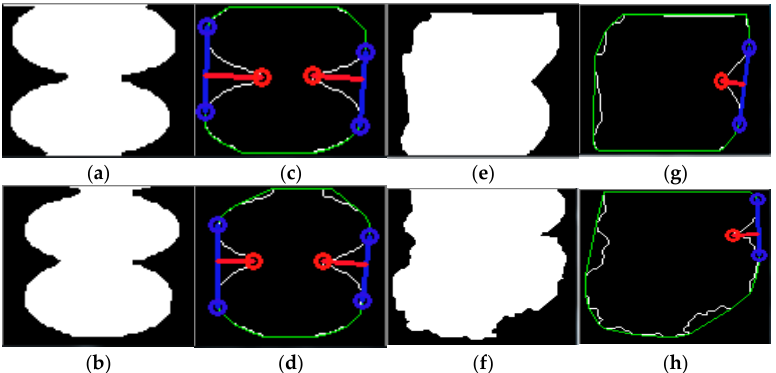
Figure 10. Insulators without ice ( a , b ) and their convexity hulls and defects of adjacent sheds ( c , d ), and insulators with ice ( e , f ) and their convexity hulls and defects of adjacent sheds ( g , h ) in Group